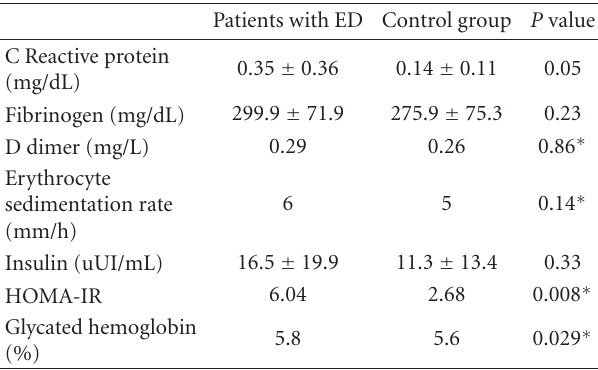
Table 4: Mean (SD) of CRP, fibrinogen, D-dimer, ESR, insulin, HOMA-IR, and glycated hemoglobin in patients with ED and their respectively controls (mean ± SD when normally distributed, median when nonnormally distributed).